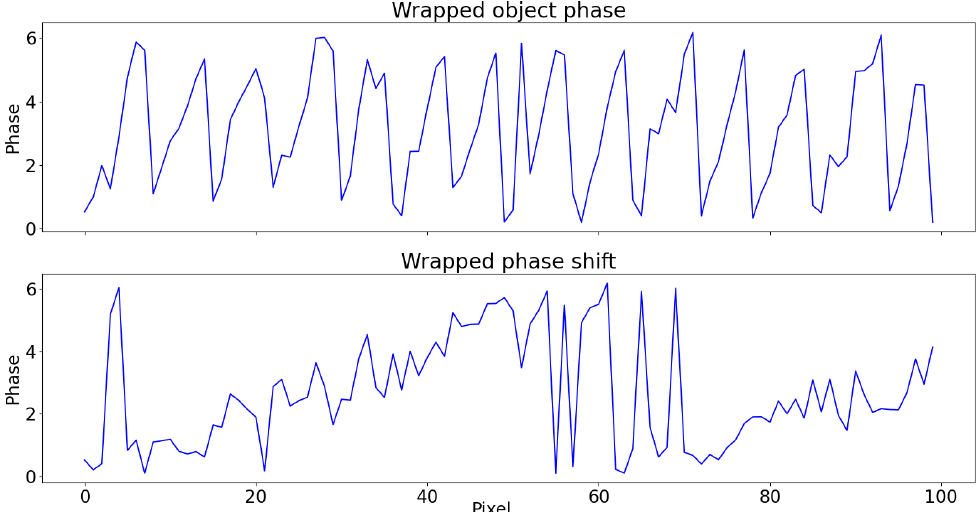
Figure 6. ( Top ) The wrapped object phase Φ w and ( Bottom ) wrapped phase shift ∆ Φ w with the same white noise ( σ = 0.6) added.